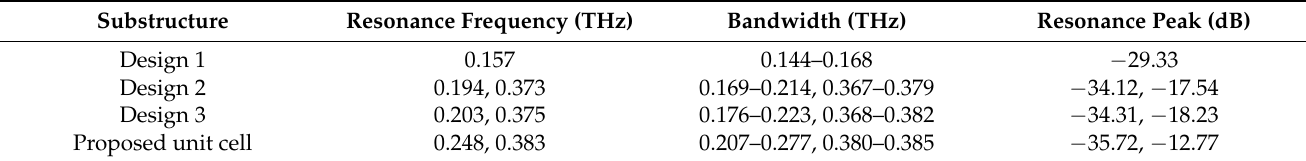
Table 2. The transmission coefficient (S21) of sequential unit cell